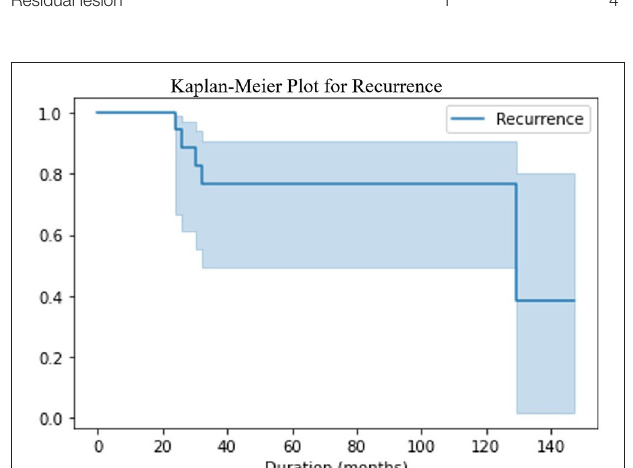
FIGURE 6 | The Kaplan- Meier survival plot showed that majority of the recurrences are detected in the first 36 months, but the risk of recurrence still exists even at 10 years of follow